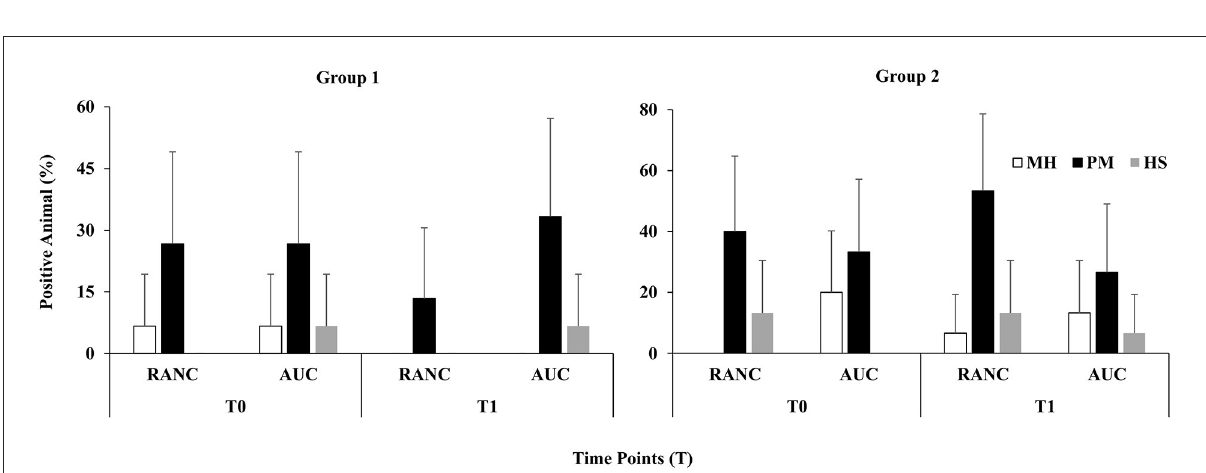
FIGURE3 Prevalence of M. haemolytica (MH), P. multocida (PM), and H. somni (HS) in TTA samples from auction-derived (AUC) and ranch-direct (RANC) cattle for Group 1 and Group 2. Isolation rates of M. haemolytica ( P > 0.05), P. multocida ( P > 0.05), and H. somni ( P > 0.05) did not differ between AUC and RANC at T0 and T1 in both feedlots. The error bars represent 95% confidence